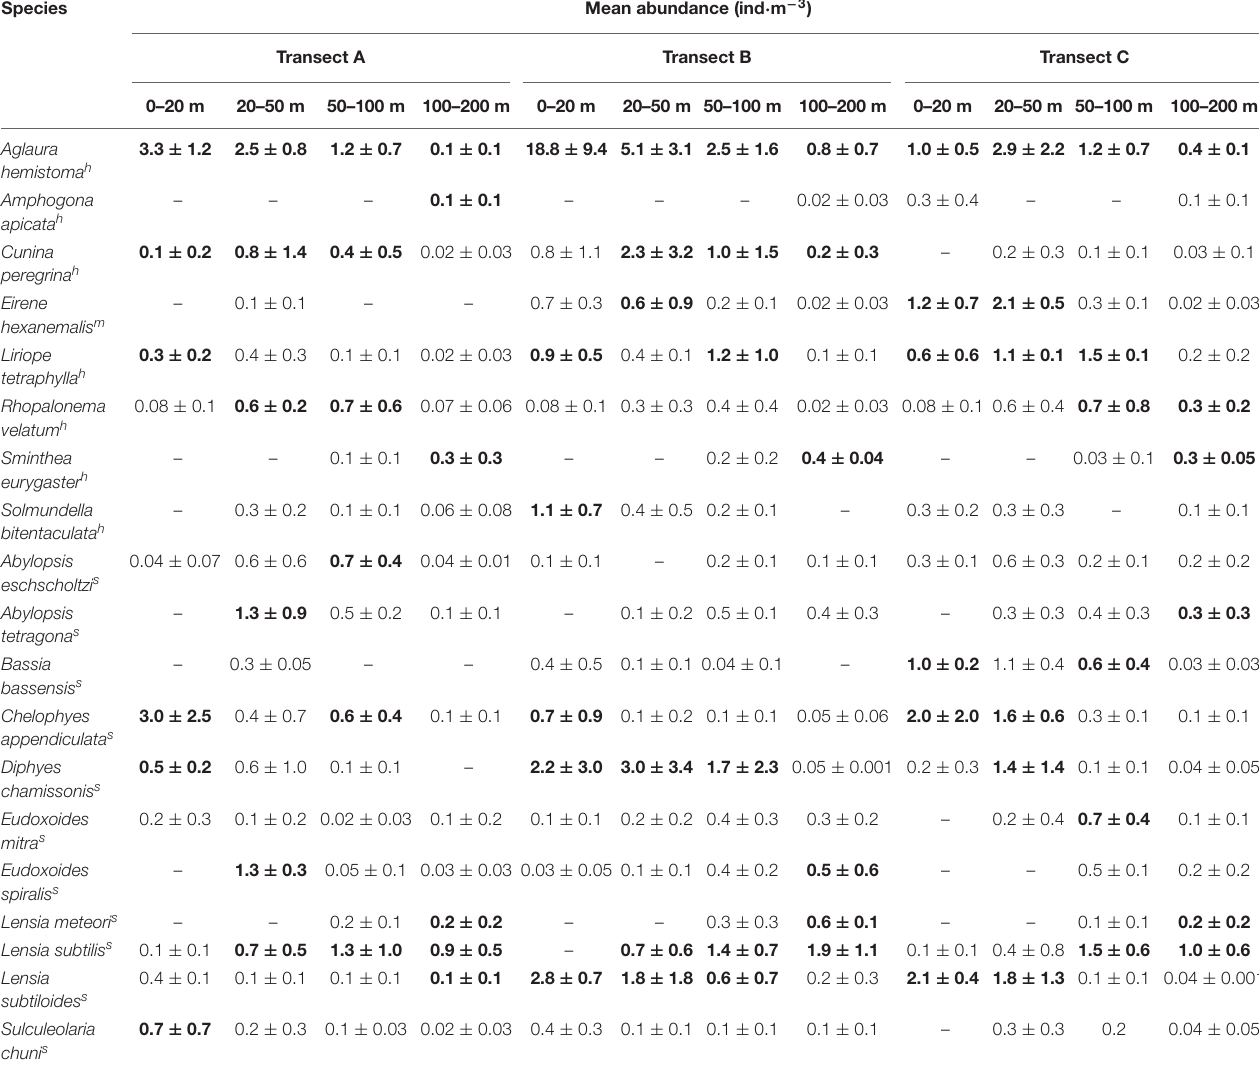
TABLE 2 | Mean abundance of dominant species at each layer for three